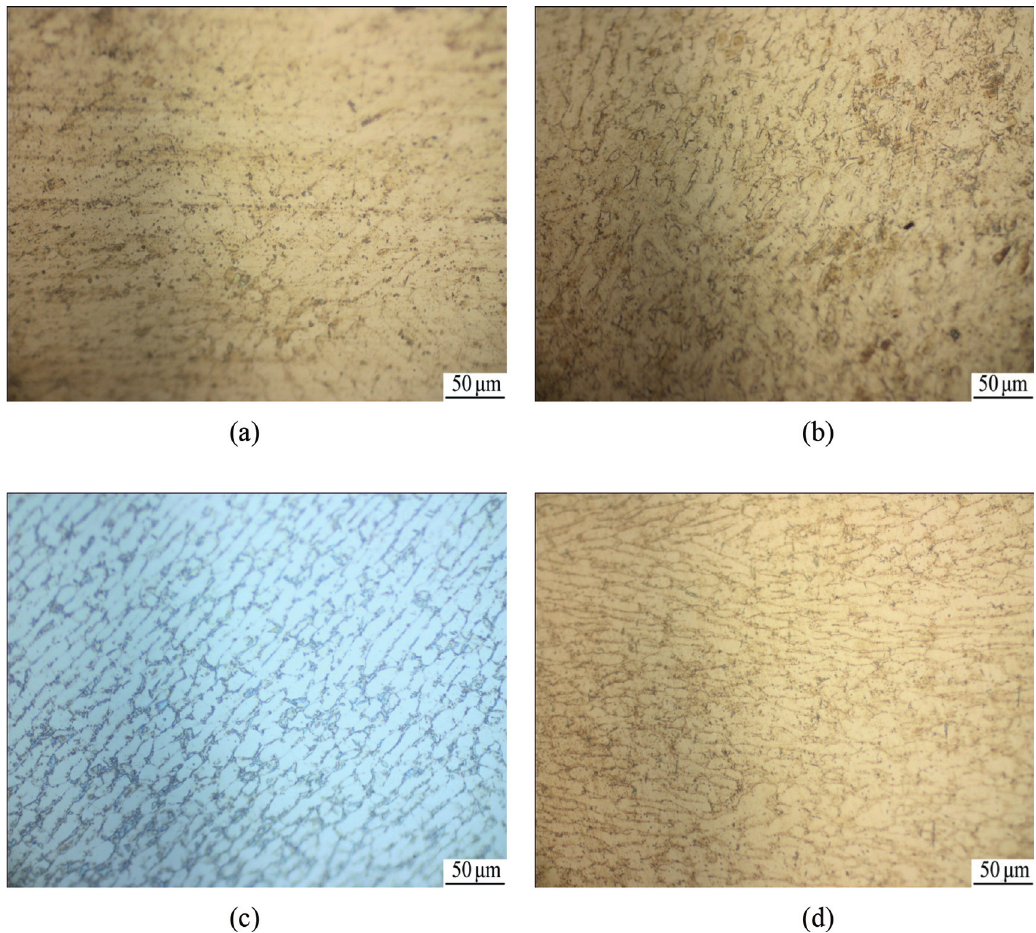
Figure 11 : Microstructures of Ti – 6Al – 4V specimens deformed at 1,123 K and different strain rates: (a) 0.01 s − 1 , (b) 0.1 s − 1 , (c) 1 s − 1 , (d) 10 s − 1 .